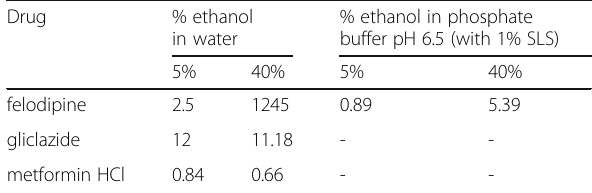
Table 5 Influence of ethanol on the relative saturated solubility of three drugs in different media (data from reference (Levina et al.